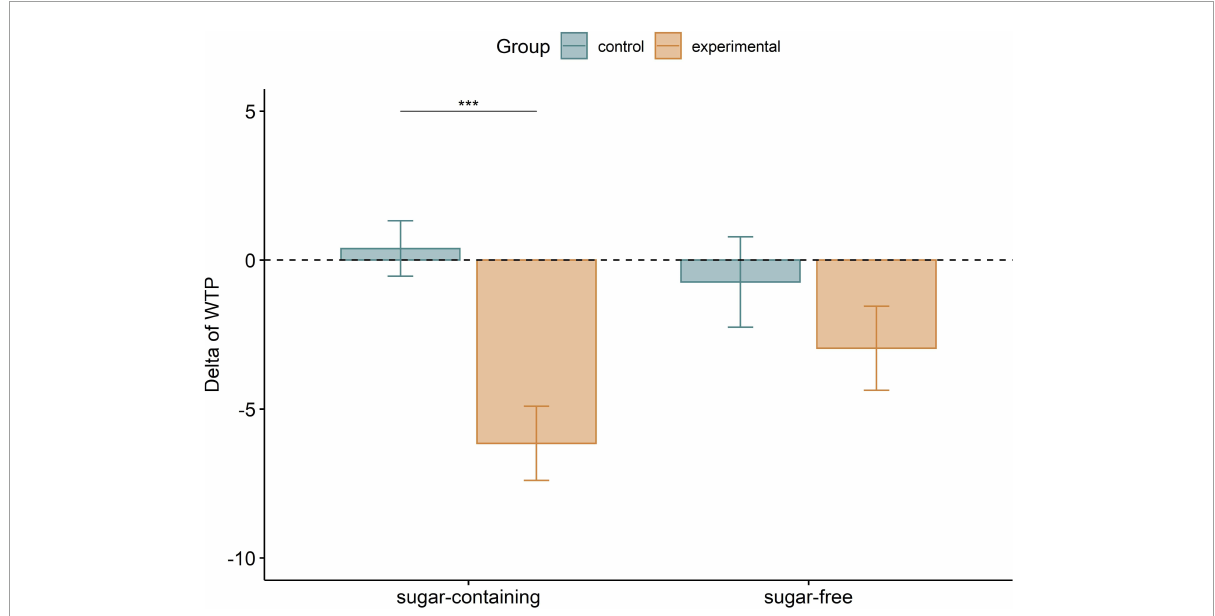
FIGURE3 Delta of WTP by group and condition. Due to the problem of p -values associated with large samples (70), we first averaged the data of each participant and only then applied pairwise t -tests, in order to limit the probability of Type I error. Error bars denote mean ± standard error (SEM), after averaging within each participant. The delta of WTP for sugar-containing products was significantly lower for the experimental group as compared to the control group ( t = 4.210, Bonferroni corrected p = 0.0003, Cohen’s d = 1.210), but the delta of WTP for sugar-free products was not statistically different between the two groups ( t = 1.070, Bonferroni corrected p = 0.578, Cohen’s d = 0.309). It is worth mentioning that the interaction between Group and Condition on the delta of WTP was also found significant in these averaged data, as assessed by a two-way mixed ANOVA [ F (1,46) = 5.15, p = 0.028], in line with the significant interaction detected by Model 1. *** p <